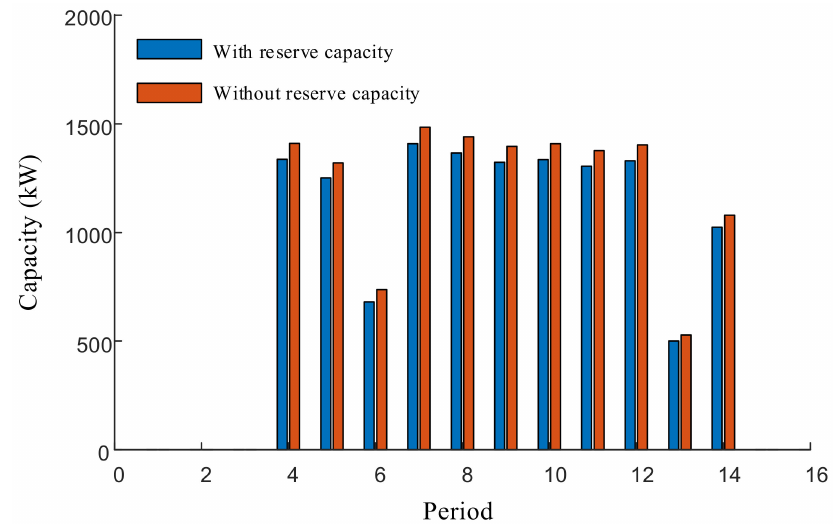
Figure A3. The optimal bidding strategy with and without reserve capacity.